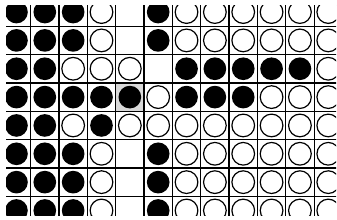
Figure 44. WHITE captures.